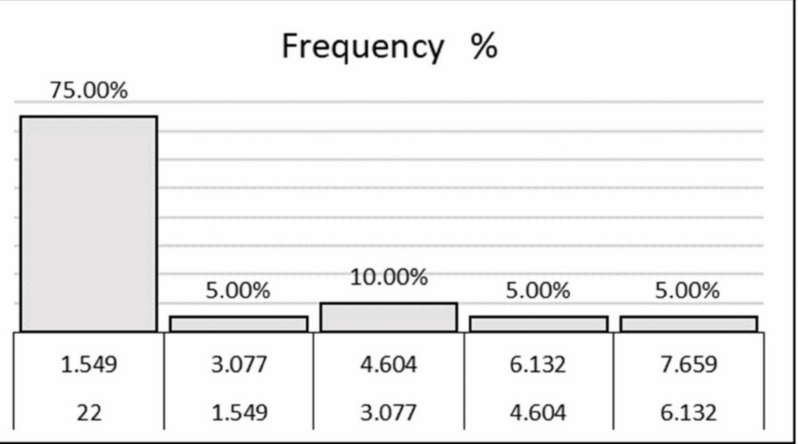
Figure 4. National positioning rankings. Note: five (5) groups are formed, and the relative frequency is shown in the